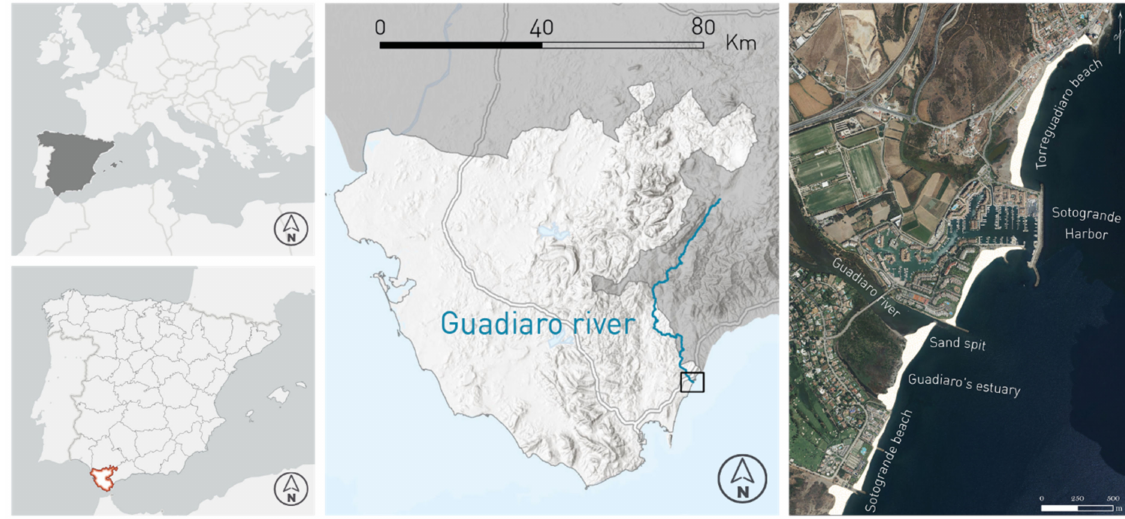
Figure 2. Study area: Guadiaro river mouth (San Roque, Cadiz),